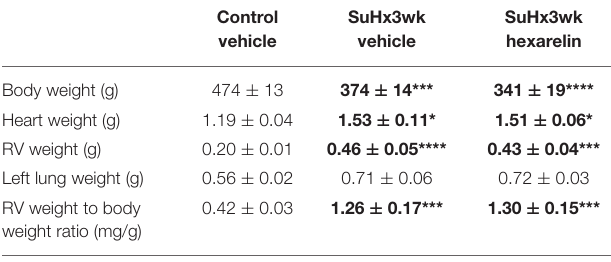
TABLE 1 | General animal characteristics in study 2.